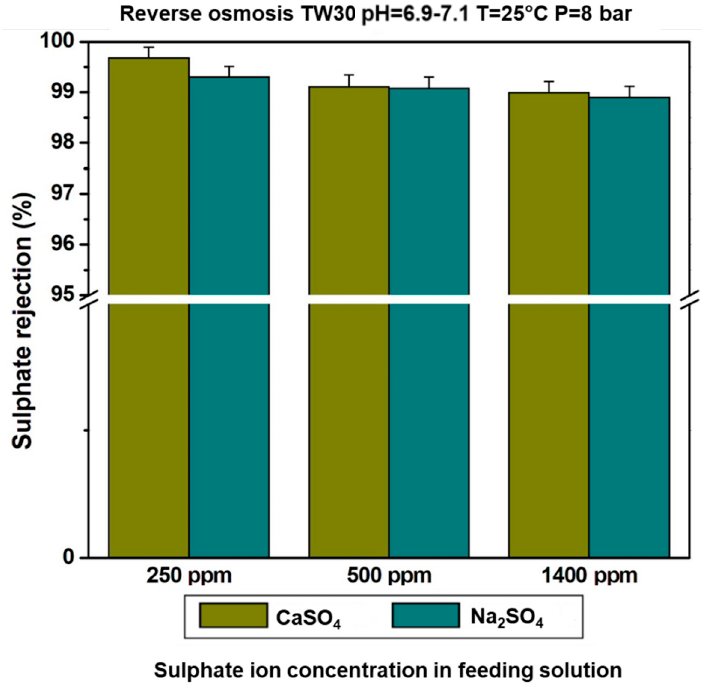
Figure 7. Counter ion effect on sulphate ion rejection with the reverse osmosis TW30 membrane.